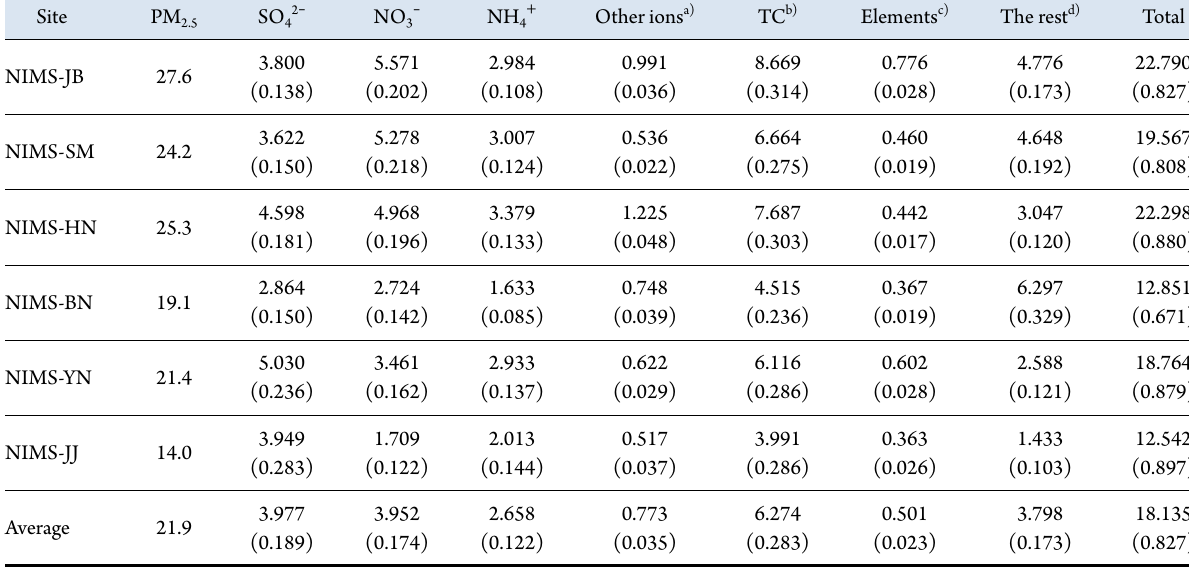
Table S2. A summary of average concentrations (μg/m 3 ) and mass ratios for major species, Total Carbon, 5 other ions and 14 elements